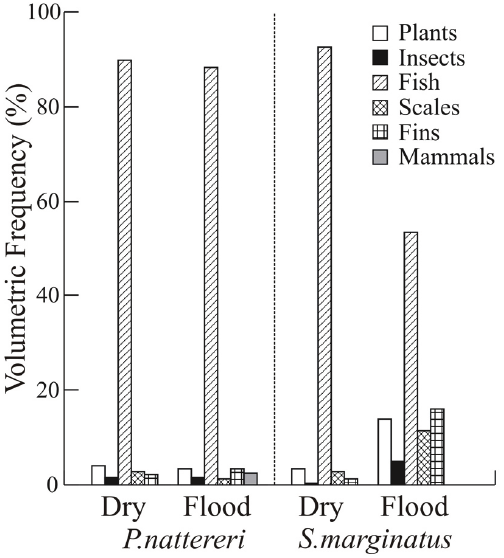
Figure 2. Volumetric frequency of food items in Pygocentrus nattereri and Serrasalmus marginatus , in the flood and dry seasons, in the Negro River, Nhecolândia region, Pantanal, from October 2005 through August